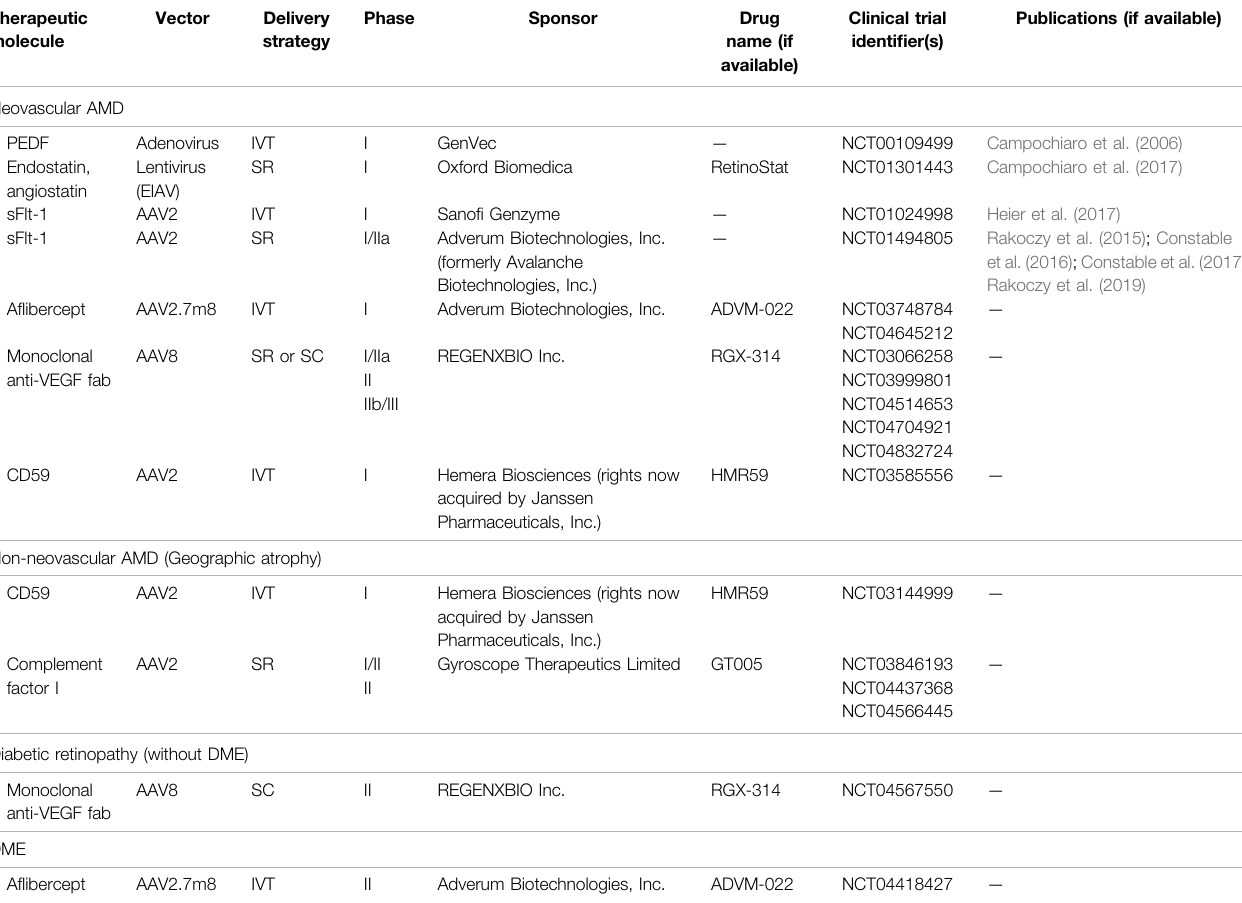
TABLE 2 | Clinical trials for “ ocular biofactory ” gene therapies in age-related macular degeneration and diabetic retinopathy. Therapeutic